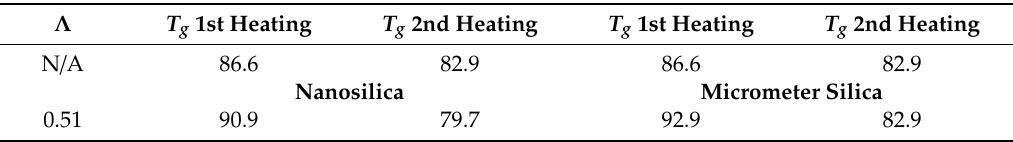
Figure 8. DMA analysis of the epoxy coatings with different silica particle sizes but same Λ value of 0.51. Table 5. T g of the coatings estimated from 1st and 2nd DSC heating curves for samples with nanosilica and micrometer sized silica. N / A = not